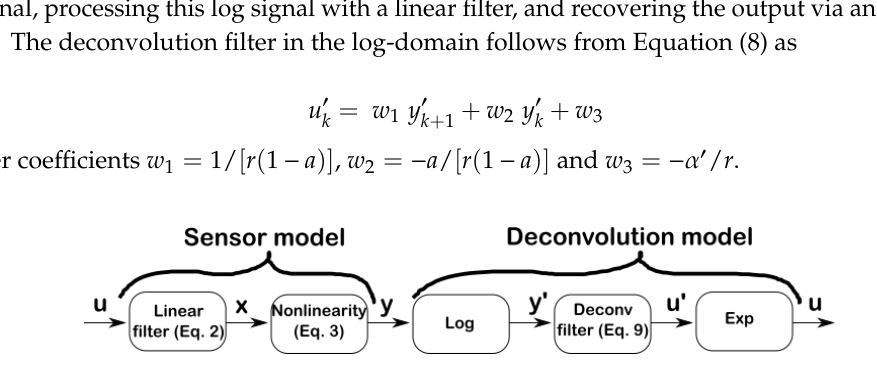
Figure 5. Deconvolution in the log-domain based on the sensor model Equations (2) and (3). The deconvolution operation consists of taking the logarithm of the MOX signal, processing this log signal with a linear filter (Equation (9)), and recovering the output via an exponential